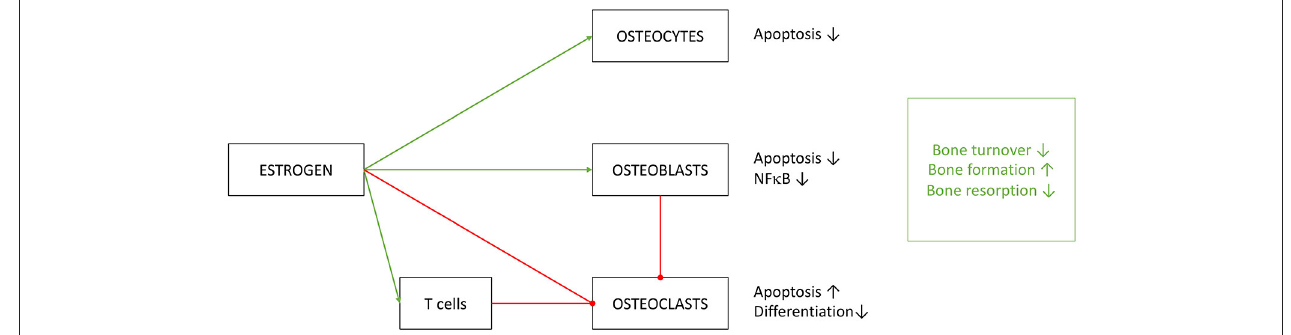
FIGURE 6 | Effects of estrogen on cells of osseous heritage. The simplified presentation highlights inhibitory (red) effects on osteoclasts and promoting (green) effects on osteoblast and osteocytes. Estrogen effects are in part executed by T cells, especially on OC metabolism. Results of estrogen interference are enhanced bone formation with decreased turnover and